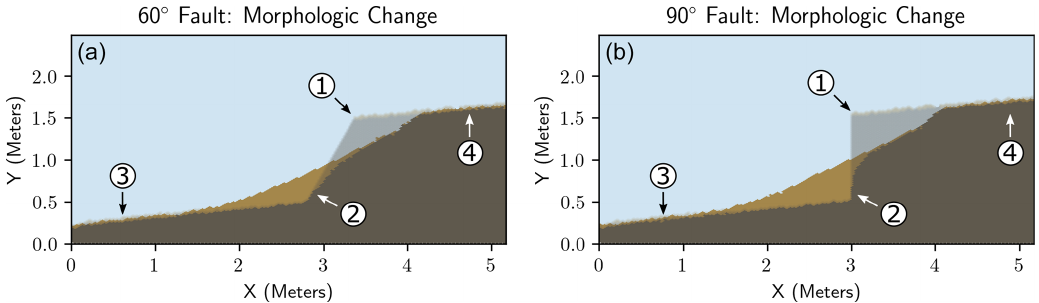
Figure 5. Example of the change in fault-scarp morphology and colluvial wedge development in both the (a) 60 ◦ dipping fault and (b) 90 ◦ dipping fault. The transparent zone shows the initial fault scarp. See Figs. 3 and 4 for the legend. (1) The upper free face of the scarp erodes headward by both lateral collapse and by erosion from mobile regolith production as well as mobile regolith disturbance processes. A small knickpoint-like ledge may be visible if the scarp has not fully diffused. (2) A small trace of the fault free face is buried by the colluvial wedge, whereas the fault trace higher above has been eroded. The colluvial wedge volume is larger for the 90 ◦ dipping fault due to the increased accommodation space. (3) The mobile regolith on the hanging wall is partly buried by the colluvial wedge, whereas the still-exposed areas continue to develop over time. (4) The mobile-regolith-forming processes on the upthrown footwall continue and produce sediment that migrates downhill and is deposited onto the colluvial